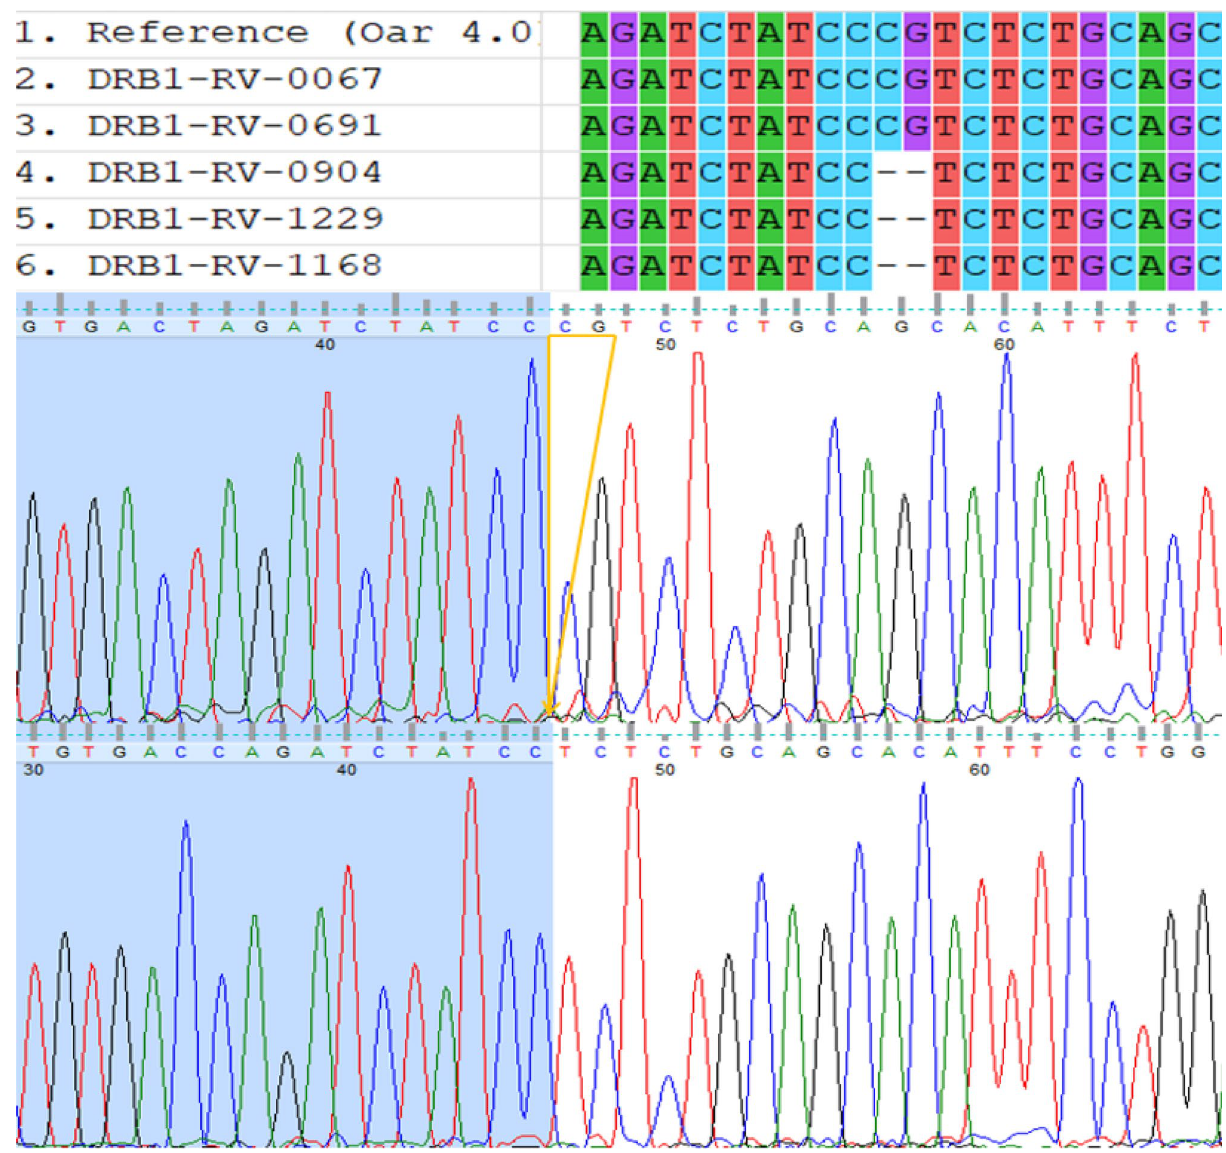
Figure 3. Alignment of DRB1 haplotypes and physical position of 2 bp del variant. Last three sequence in the alignment and the bottom figure in the chromatograms are deleted